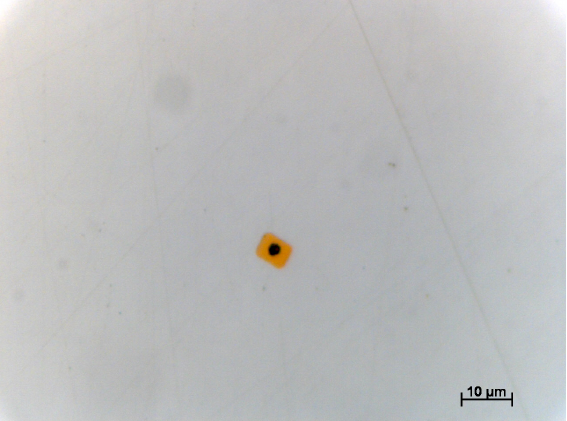
Figure 1. Micrograph of a titanium nitride (TiN) particle at the surface of an etched maraging steel sample.